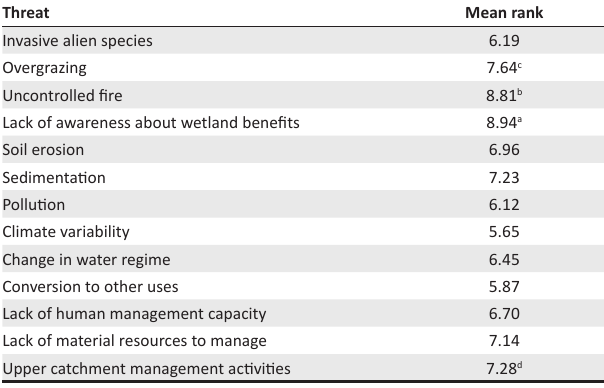
TABLE 4: Perceived wetland threats to private owners: Kendall’s W Test (ranks). Threat